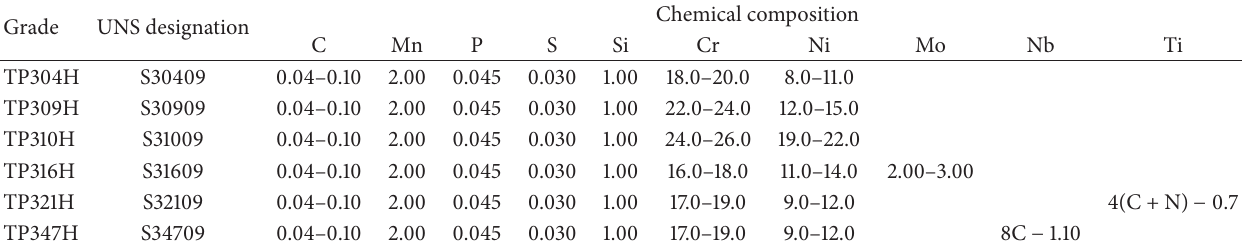
Table 1: Chemical composition of austenitic stainless steels evaluated as reported by ASTM A213/A213M [11].